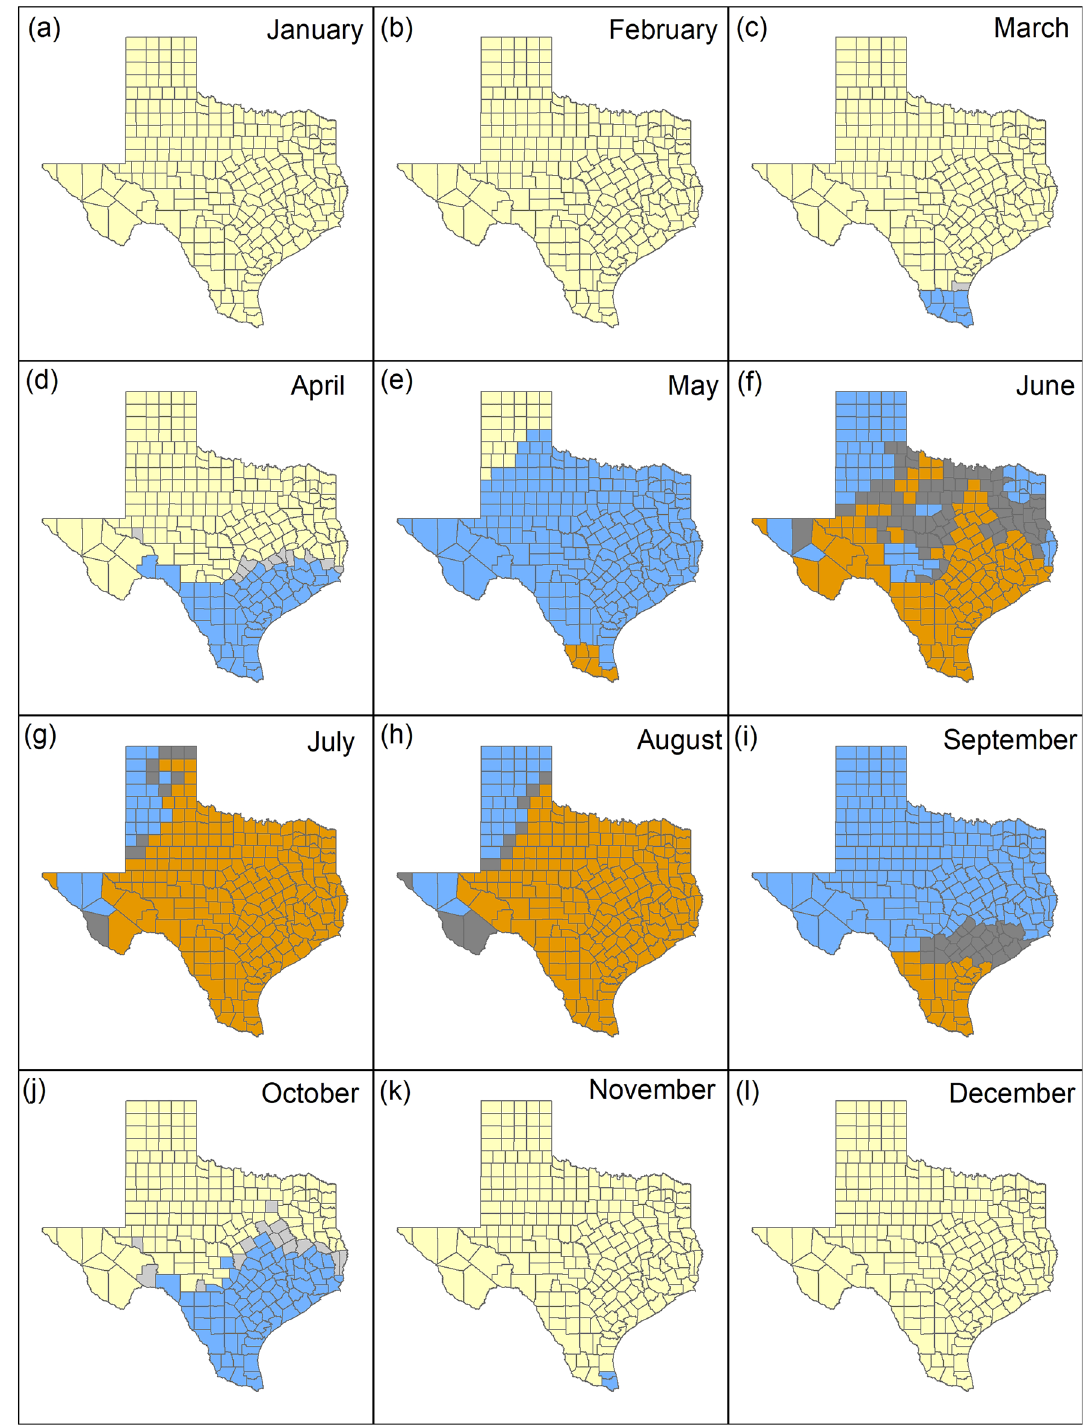
Figure 3. Monthly mean temperature (°C) from 1990 to 2019 compared to 2010–2019 for Texas aggregated by county. Yellow counties represent areas where temperatures are below the maximum clear ambient temperature in which deer can be detected (≤ 20 °C), blue counties represent areas where temperatures are below the maximum cloudy ambient temperature in which deer can be detected (≤ 27 °C), and orange counties represent areas where temperatures are above the maximum ambient temperatures for deer detection (> 27 °C). Light gray counties represent areas where temperatures increased from clear to cloudy maximum ambient temperatures and dark gray counties represent areas where temperatures increased above 27